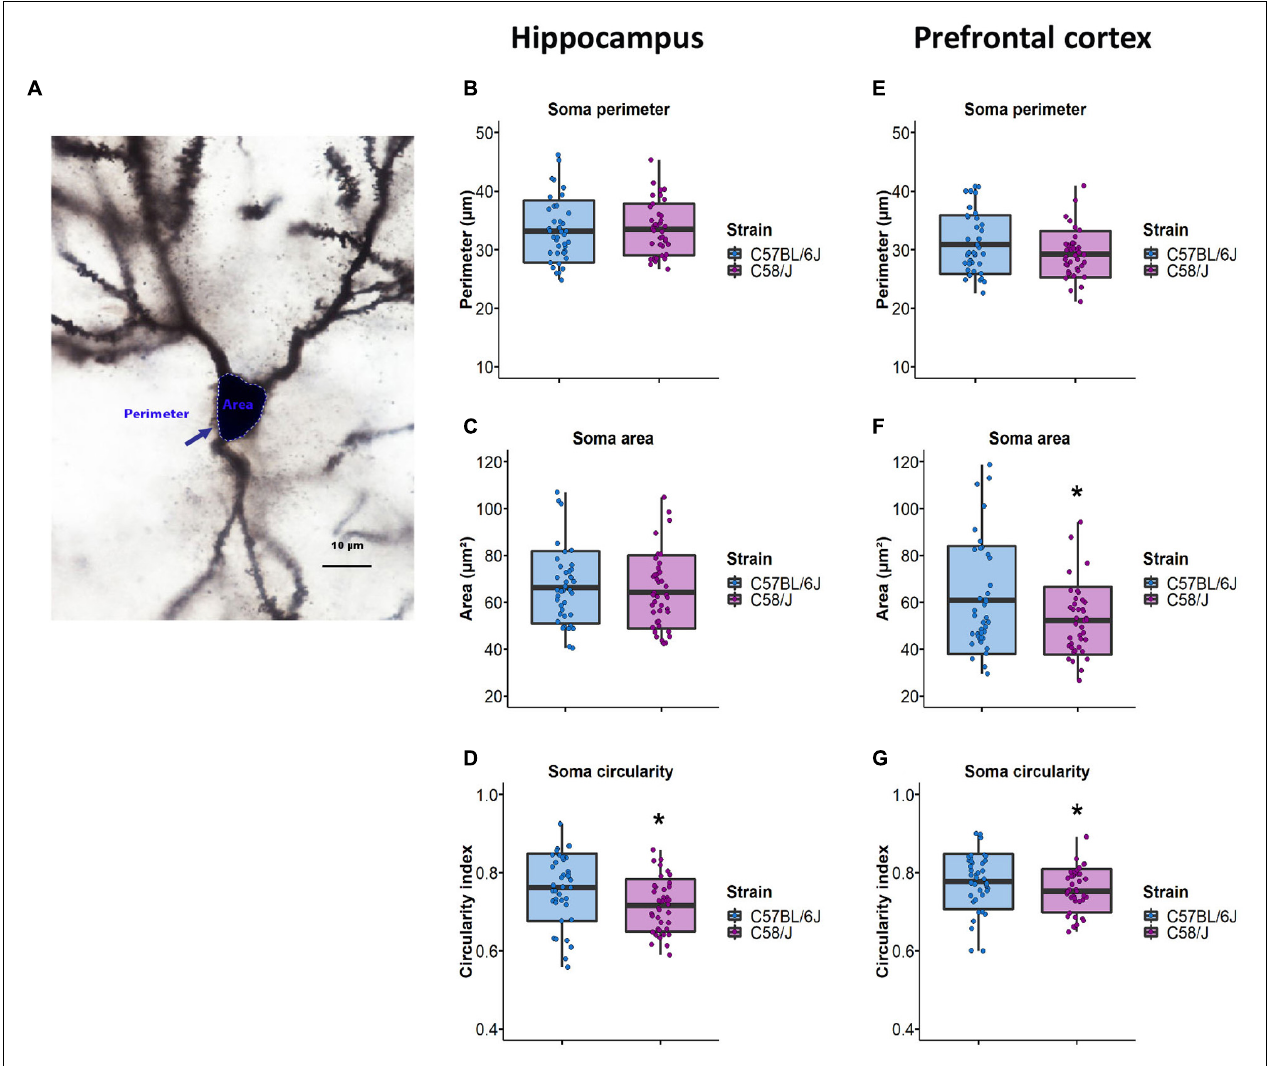
FIGURE 1 | Neuronal soma size analysis in the hippocampus and the prefrontal cortex of C58/J mice. Representative image of soma perimeter and area (A) . Perimeter, area, and circularity index of pyramidal neurons soma in the hippocampus (B–D) and the prefrontal cortex (E–G) of C57 BL/6J (neurotypical phenotype) and C58/J (autistic-like phenotype) mice. n = 40 neurons per strain, 10 neurons per mouse. t -test: * p <